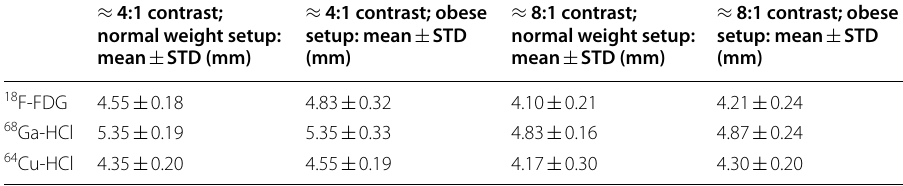
Spatial resolution is represented by the mean and standard deviation (STD) of the full width at half maximum (FWHM) of all six spheres (in mm) of the NEMA PET body phantom filled with 18 F-FDG, 68 Ga-HCl, or 64 Cu-HCl at sphere-to-background activity concentration ratios of approximately 4:1 or 8:1 and with applied cooling packs around the phantom (obese setup) or without (normal weight